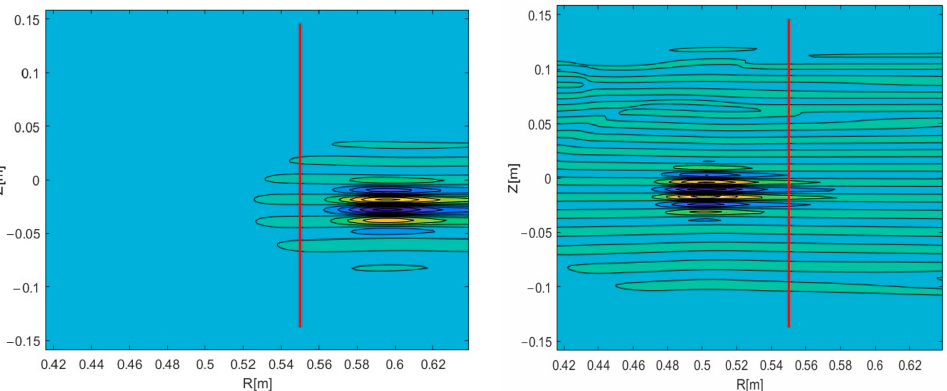
Figure 16. Two-dimensional DBS signal map for the circular filament positioned at the 48 GHz prob- ing frequency: ( left ) 39 GHz, ( right ) 55 GHz probing frequency. The red line indicates the trajectory.